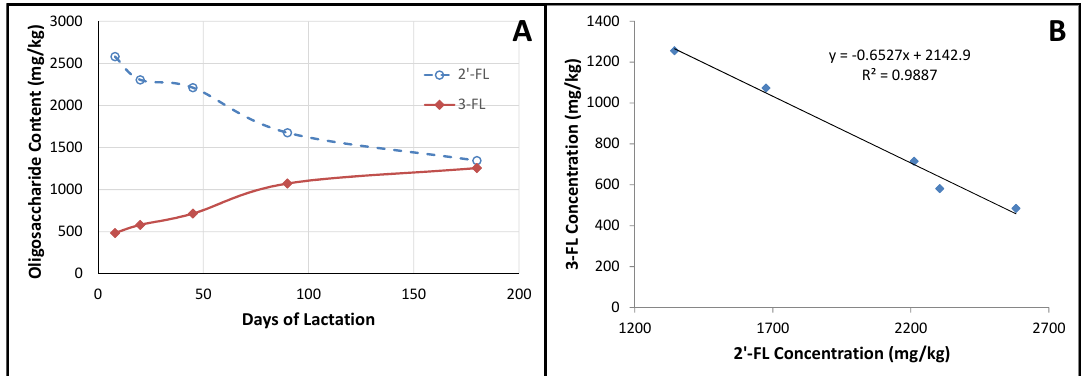
Figure 2. ( A ) Changes in 2 ′‐ FL and 3 ‐ FL concentration at different stages of lactation; ( B ) Correlation between 3 ‐ FL concentration and 2 ′‐ FL concentration.